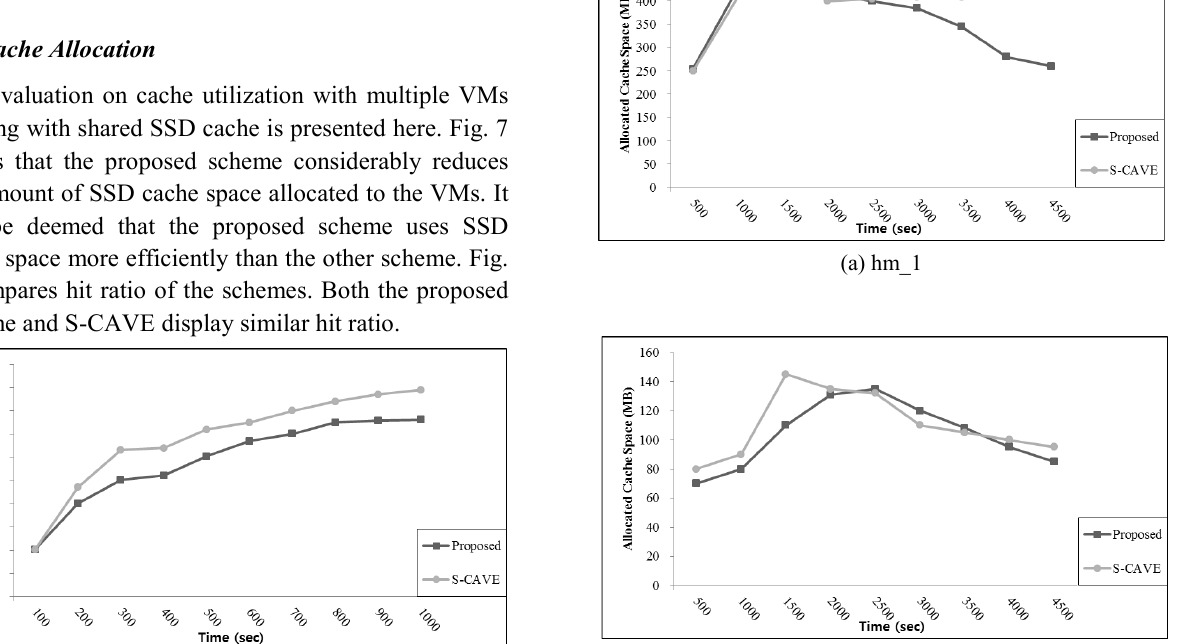
Fig. 6. The comparison of accuracies of the schemes.